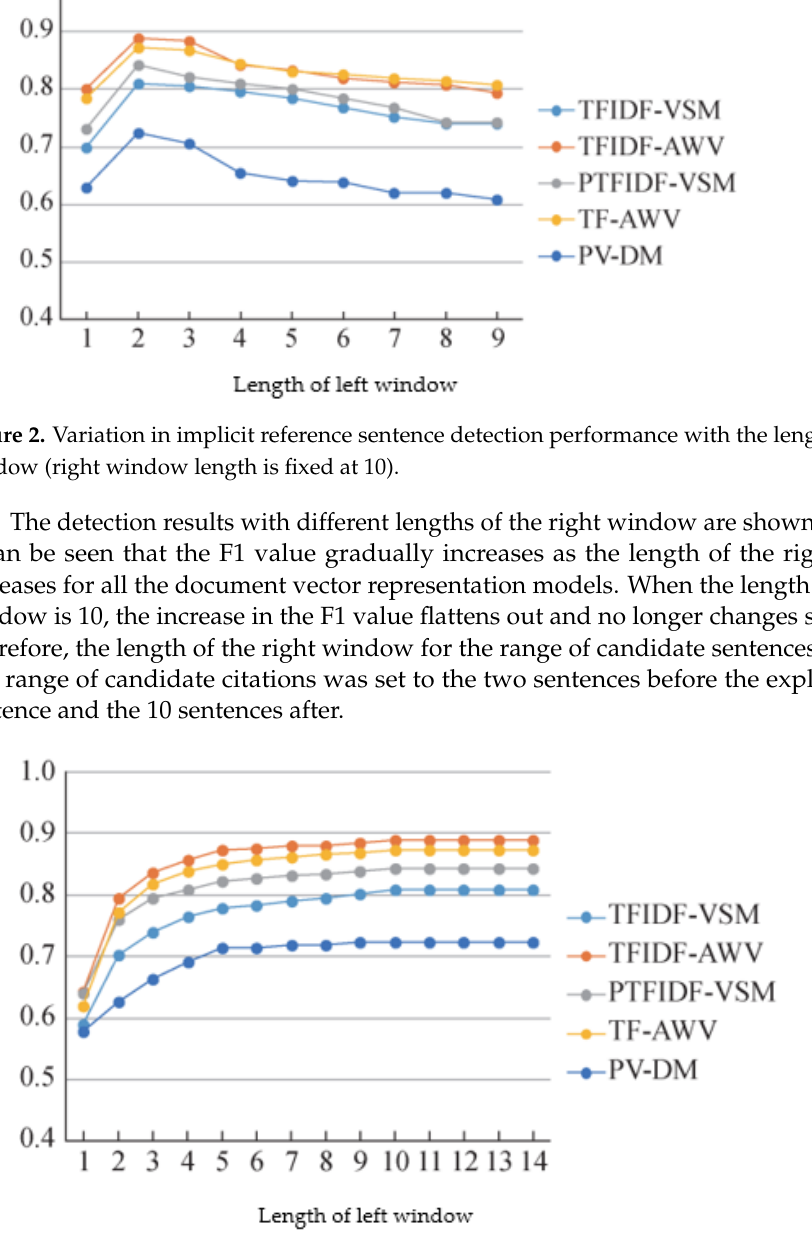
Figure 3. Implicit reference sentence detection performance as a function of right window length (left window length fixed at